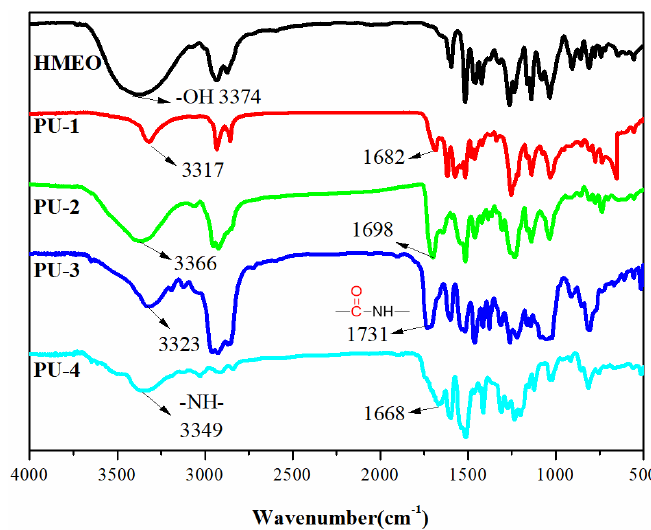
Figure 7. FTIR spectra of PUs and HMEO.